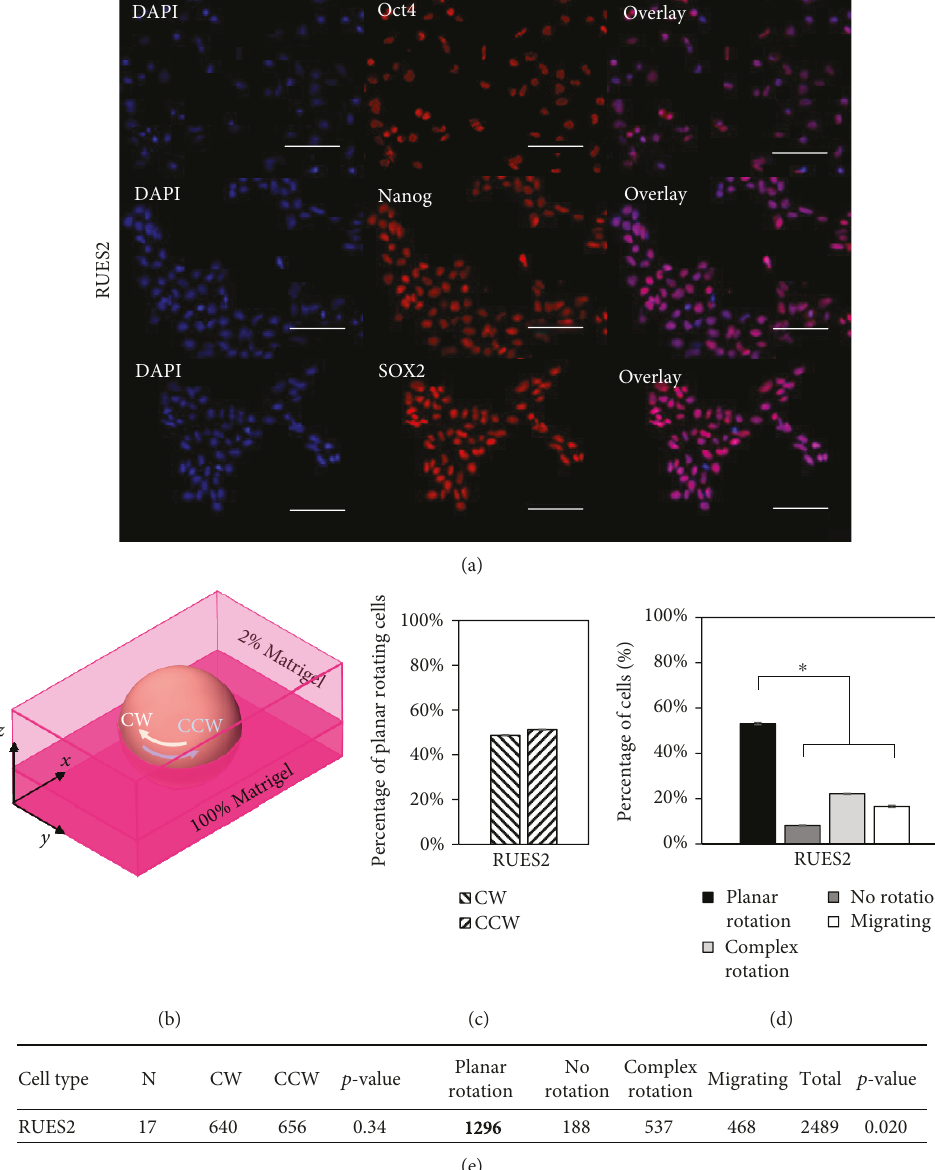
Figure 1: Human embryonic stem cell line, RUES2, displays no chiral bias. (a) Representative images of RUES2 cells expressing the nuclear marker DAPI (blue) and pluripotency markers Oct4, Nanog, and SOX2 (red). Over 95% of RUES2 cells exhibit Oct4, Nanog, and SOX2 expression. (b) A schematic showing planar rotation in the x - y plane about the z -axis. (c) RUES2 cells do not show a de fi nitive chiral bias in rotation, displaying an almost 50 :50 ratio of CW to CCW rotating cells. (d) A statistically signi fi cant number of cells rotated in plane compared to the other categories. (e) Quantitative data showing the number of cells in each category along with the number of replicate experiments ( N ). The p values indicate comparisons between CW and CCW and between planar rotation and the other three categories. Scale bars: 100 μ m; ∗ p < 0 05